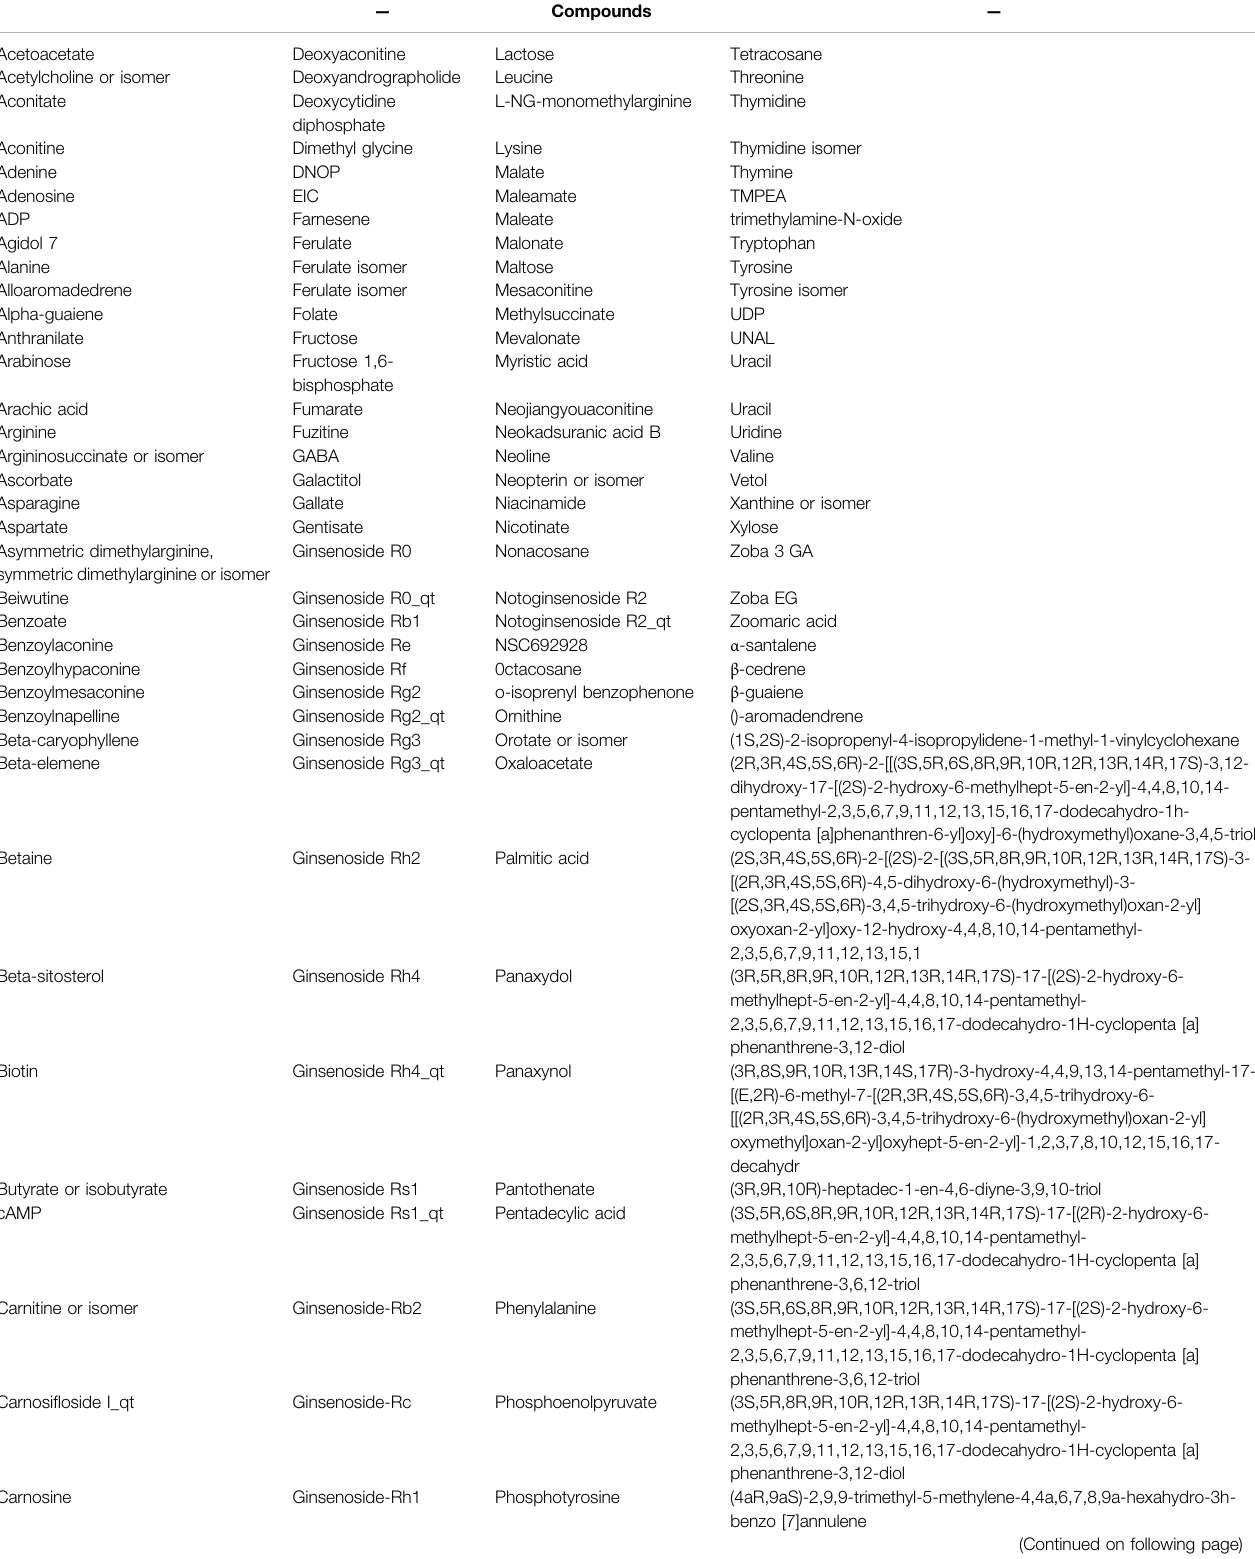
TABLE 3 | Composite compounds of Shenfu injection. —